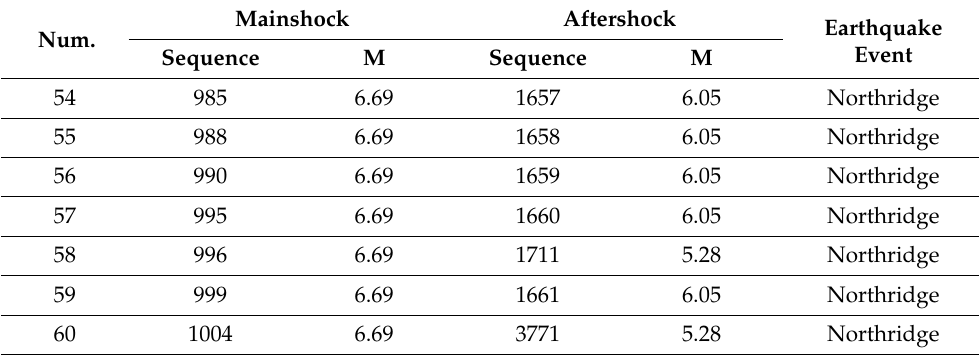
Table 1. Cont. Num.